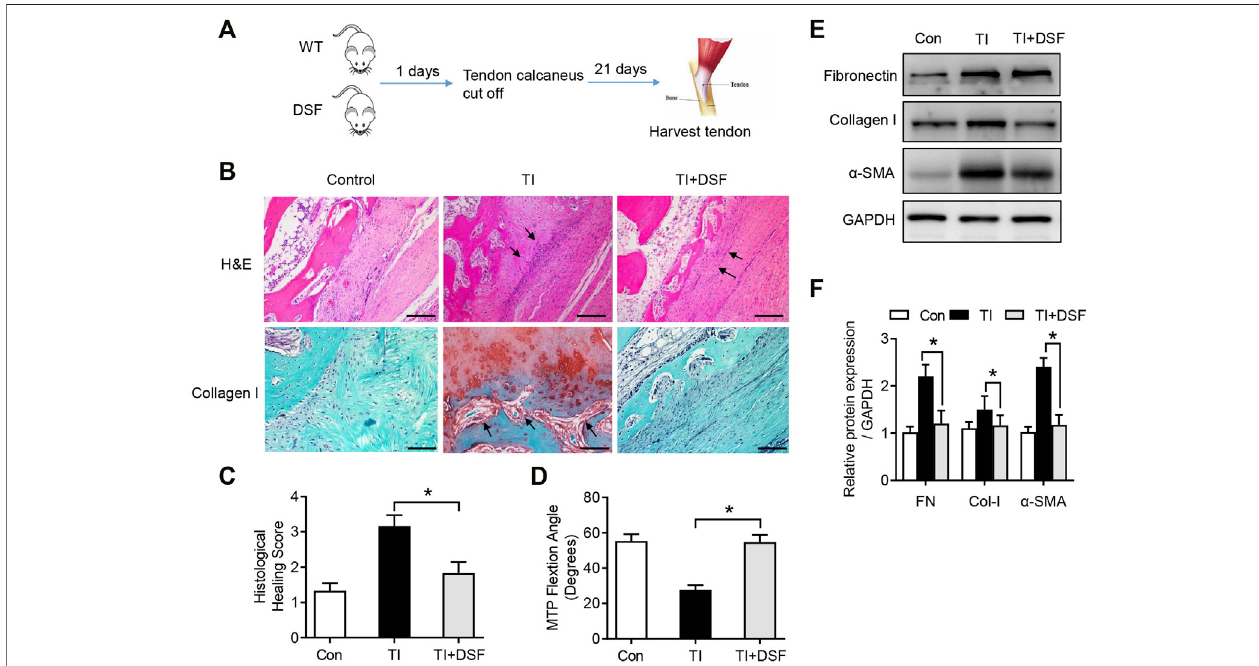
FIGURE3| DSF rescued peritendinous fi brosis inTI. (A) Thediagram ofmousemodel conduction. (B) H&Eand immunohistological stainingofCol-I inthecontrol, TI, and TI oral with DSF (50 mg/kg) mouse groups. Scale bar = 200 μ m. (C) Histological adhesion score and histological healing score from the indicated groups ( n = 6 per group). (D) MTP joint fl exion ROM of the indicated groups ( n = 6 per group). (E) Western blot analysis of FN, Col-I, and α -SMA in tendon ( n = 6 per group). Data are presented as the mean ± SEM ( n = 6) (C , D) . * p <